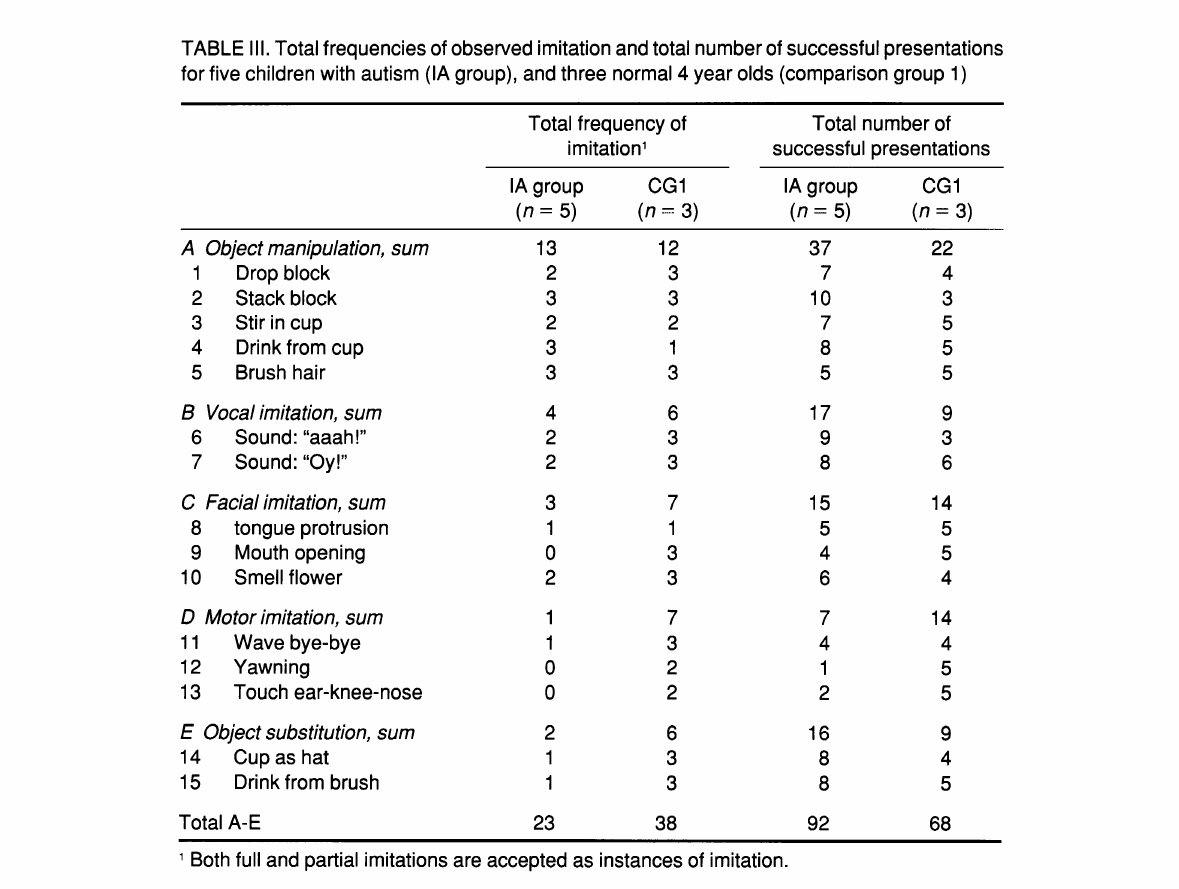
for five children with autism (IA group), and three normal 4 year olds (comparison group